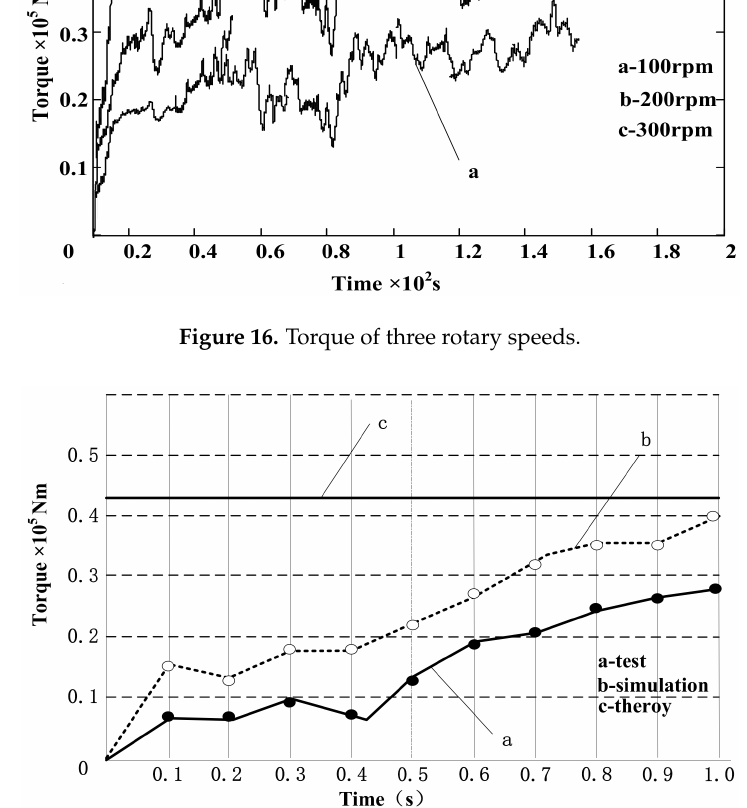
Figure 17. Contrast